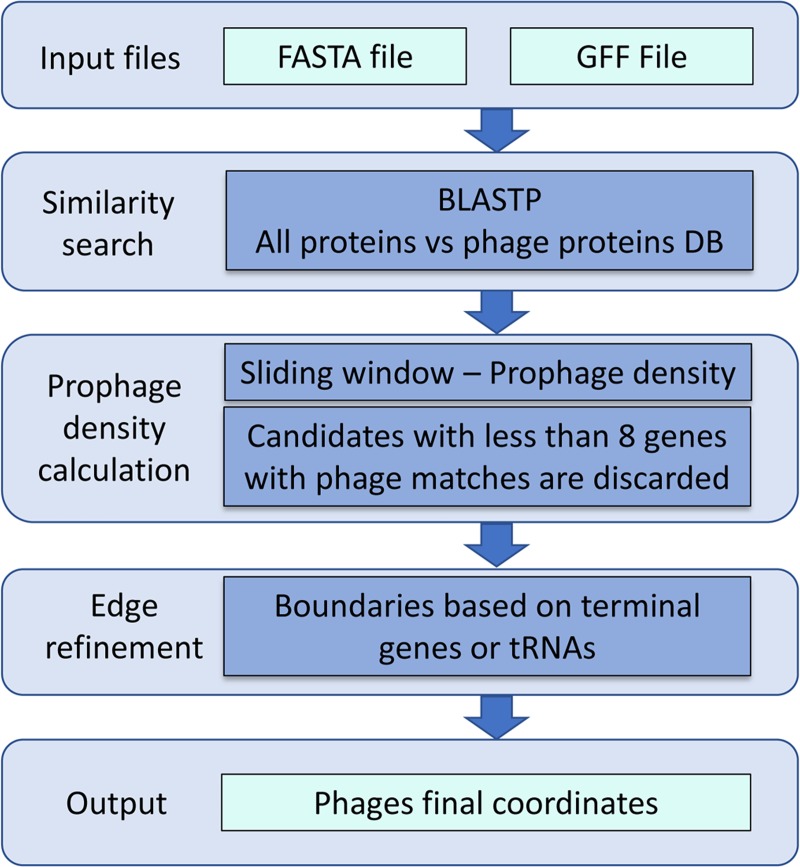
ProphET pipeline.